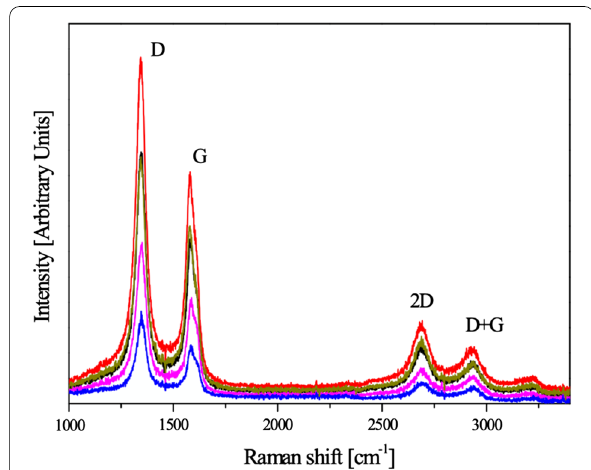
Fig. 3 Raman spectra taken in 5 different places of carbon fiber